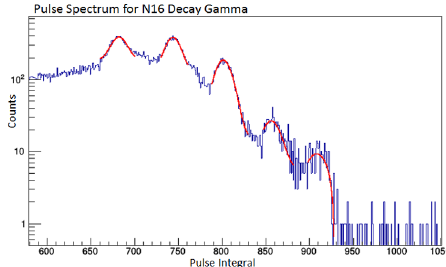
Fig. 4. Pulse spectrum for 16 N decay gamma. The five gamma peaks of a decaying 16 N ranging from 5.1 MeV to 7.1 MeV as detected in a